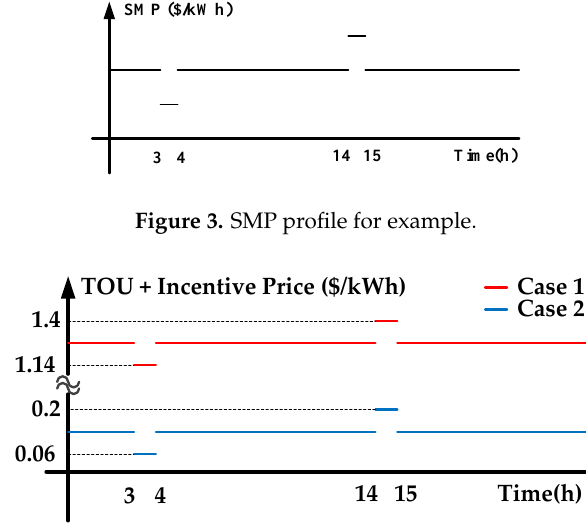
Figure 4. Two cases of sums of incentive prices and time-of-use (TOU) prices.